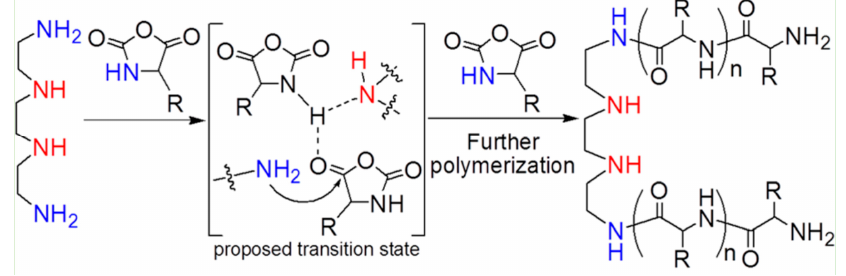
Figure 17. Accelerated amine mechanism trhough monomer activation (AAMMA). Reproduced with permission from reference [86].